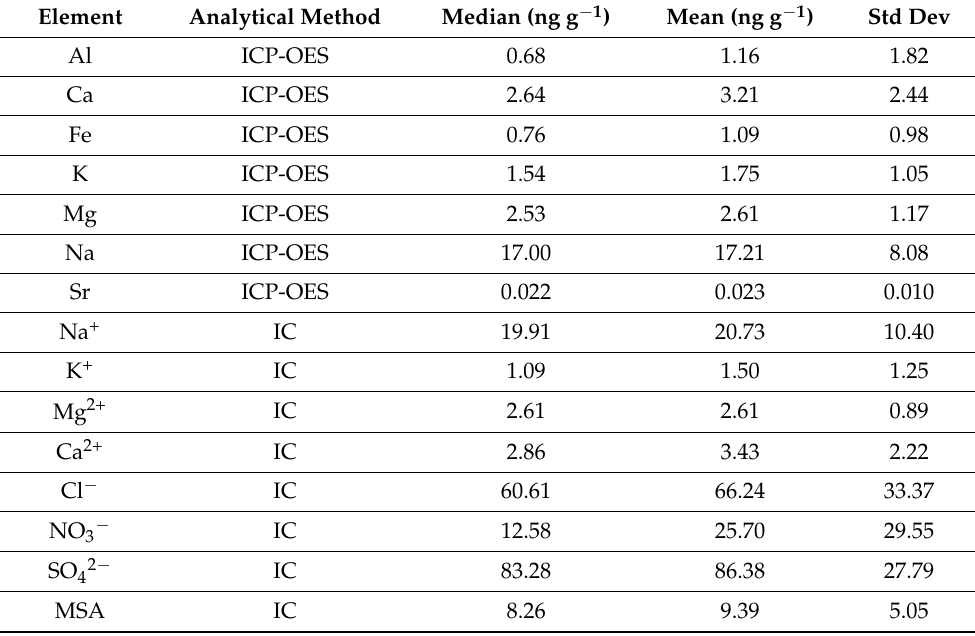
Table 1. Median, mean (both expressed in ng g − 1 ) and standard deviation of every component analyzed. For each of them, the analytical method used is specified.